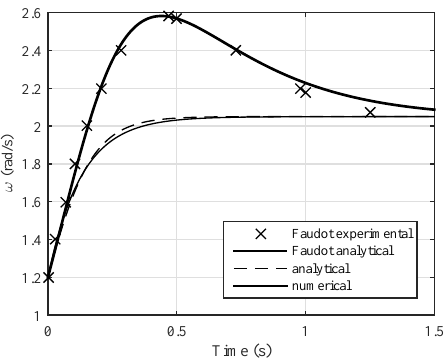
Figure 9. An attempt at recreating the plot in Figure 6 of [1]. Crosses mark points on the experimental curve, taken from that figure by hand